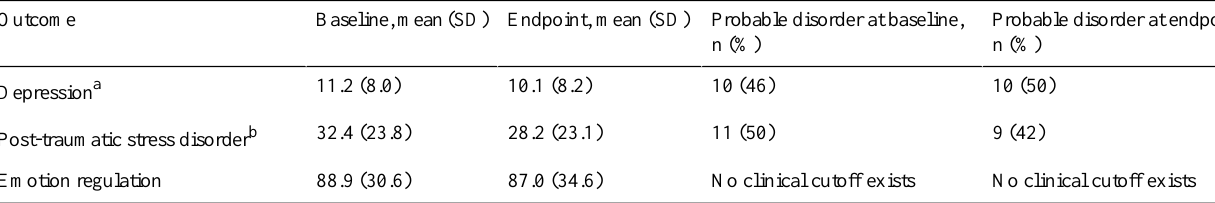
Table 1. Clinical characteristics of sample at baseline and endpoint (1